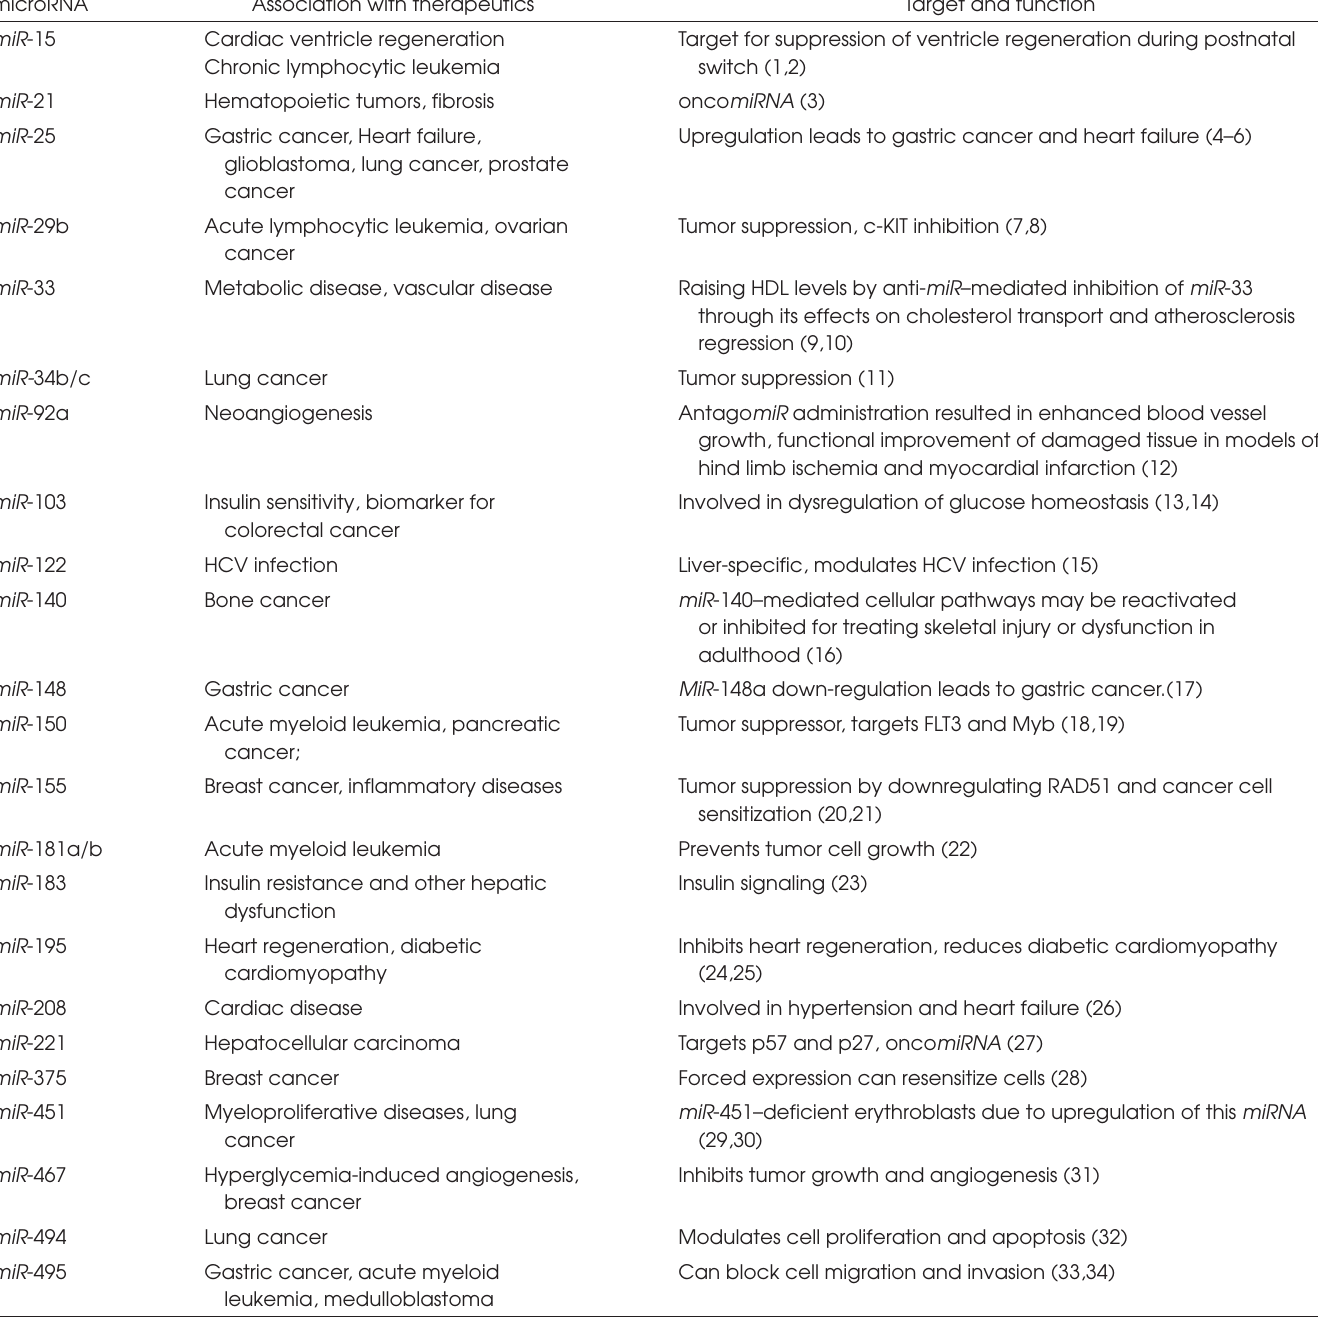
Table 1. Preferred miRNA targets in current diagnostics and therapeutics.